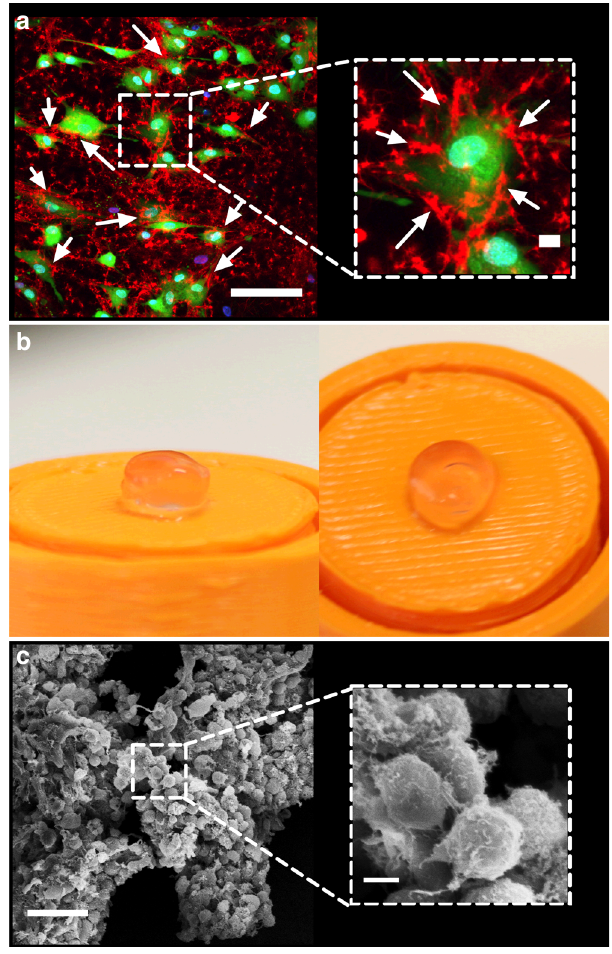
Fig. 4 Evaluation of cellular fi brin hydrogel formation. a Live-cell confocal fl uorescence micrograph (2D) showing Alexa Fluor ® 594 labelled fi brin (red) nucleation after 20 min from the surface of hMSCs stained with Calcein AM (green) and Hoechst 33342 (blue). Insert shows single cell at higher magni fi cation. Scale bars represent 100 and 10 μ m